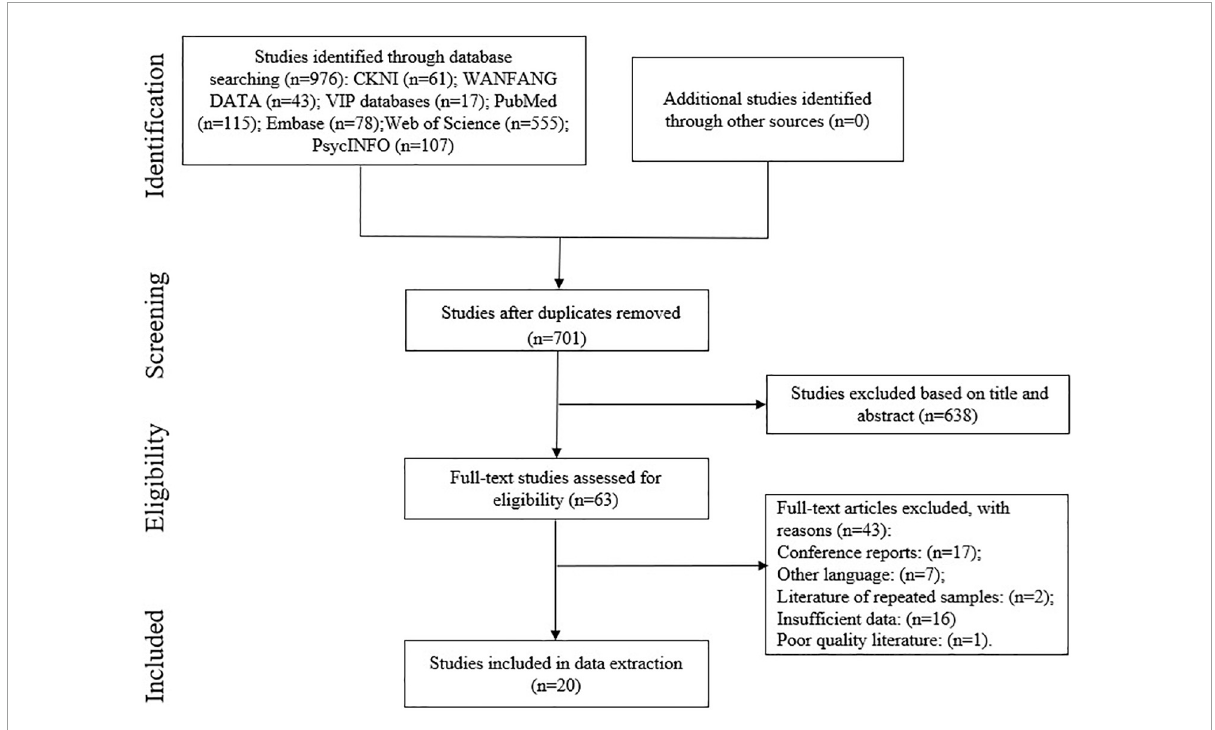
FIGURE1 Flow chart of the research selection